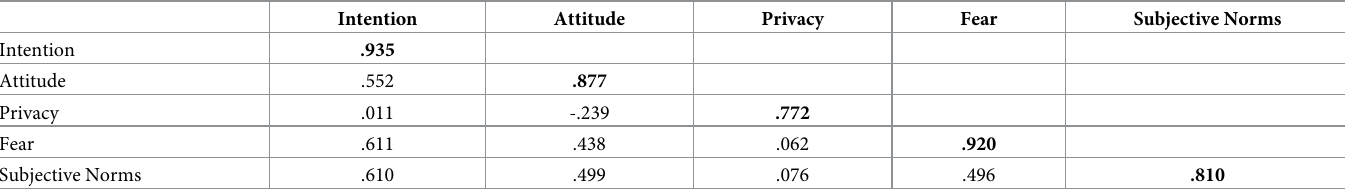
Table 5. Measurement model discriminant validity statistics.